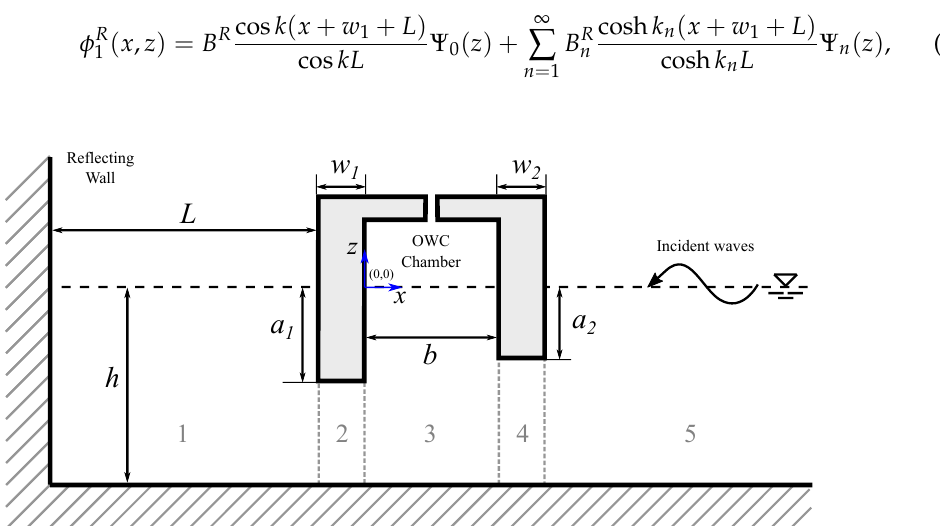
Figure 2. Side view of the interaction of water waves with a fixed-detached OWC device near a vertical